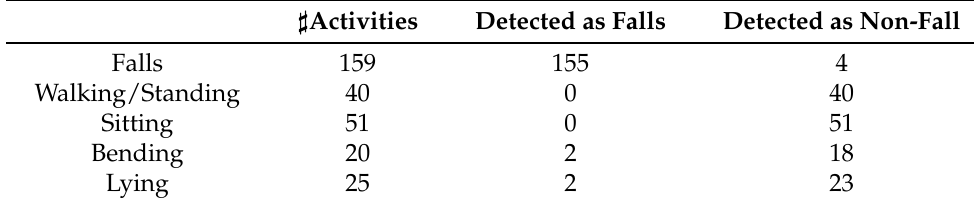
Table 11. Results of fall detection system.